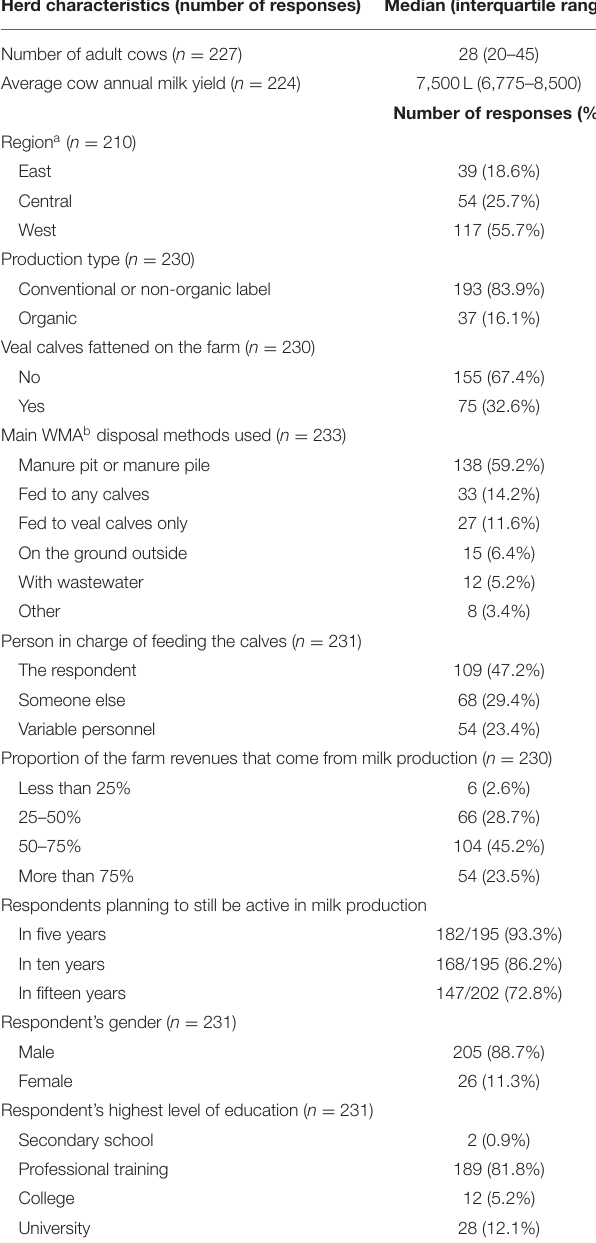
TABLE 3 | Distribution of farm characteristics of 233 Swiss dairy producers who completed the questionnaire. Herd characteristics (number of responses) Median (interquartile range) Number of adult cows ( n =